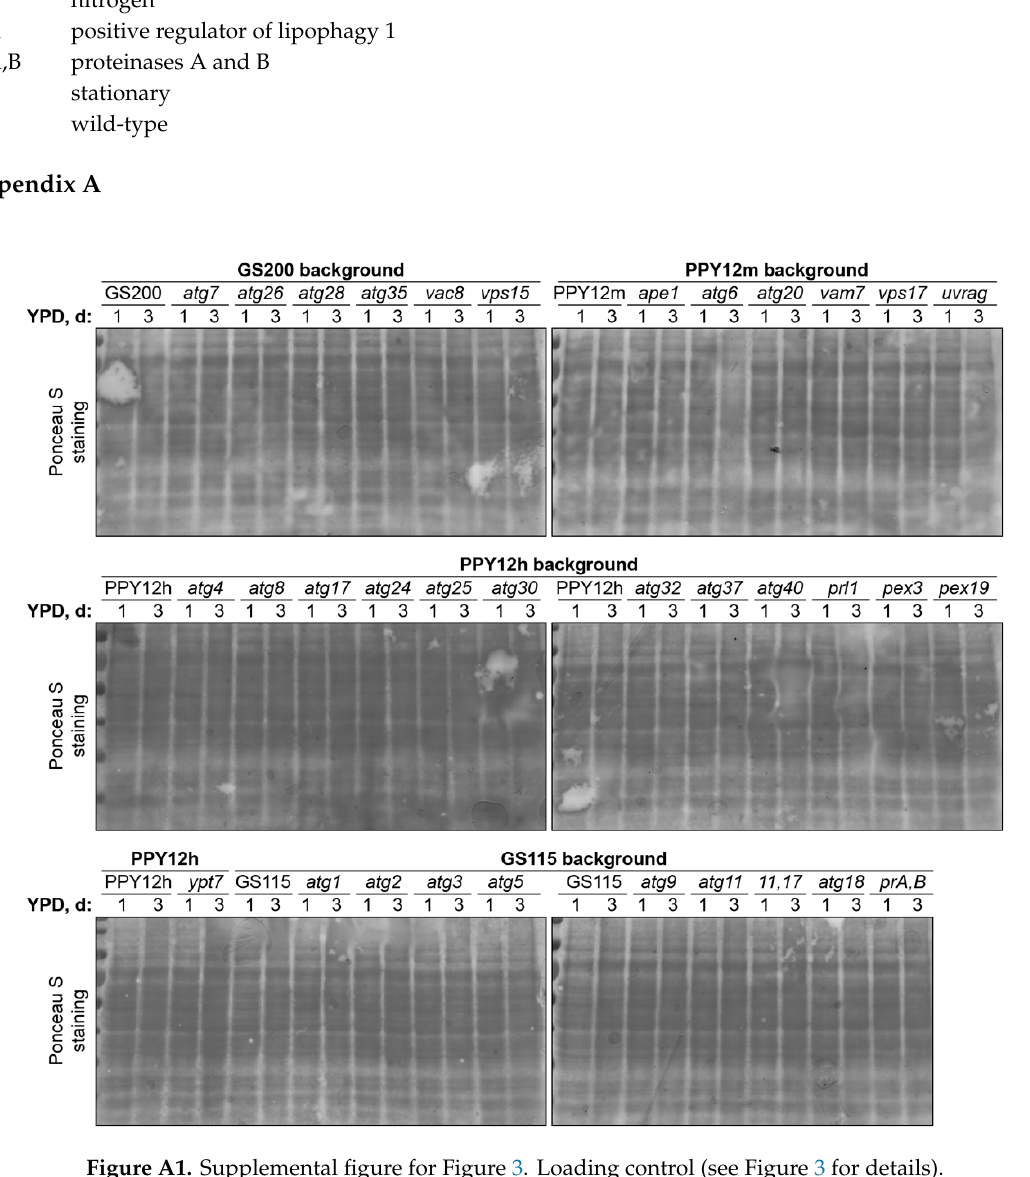
Figure A1. Supplemental figure for Figure 3. Loading control (see Figure 3 for